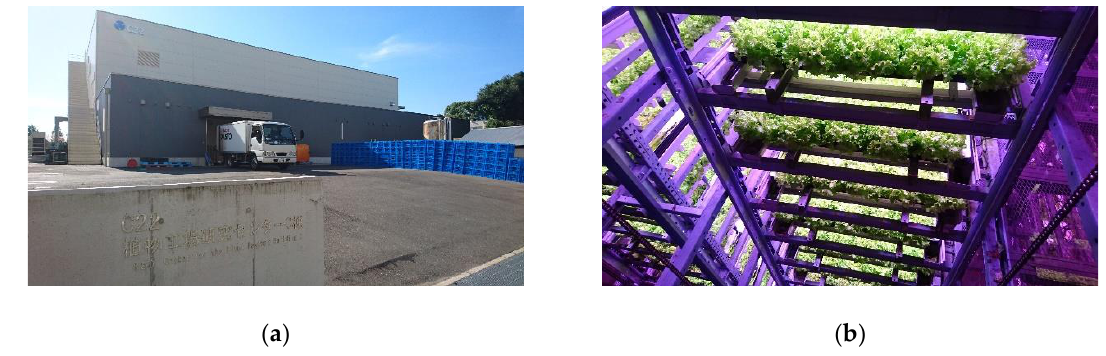
Figure 1. Closed plant production systems (CPPS) with artificial lighting use in this research at Osaka Prefecture University: ( a ) External view; ( b ) internal view of the culture room.